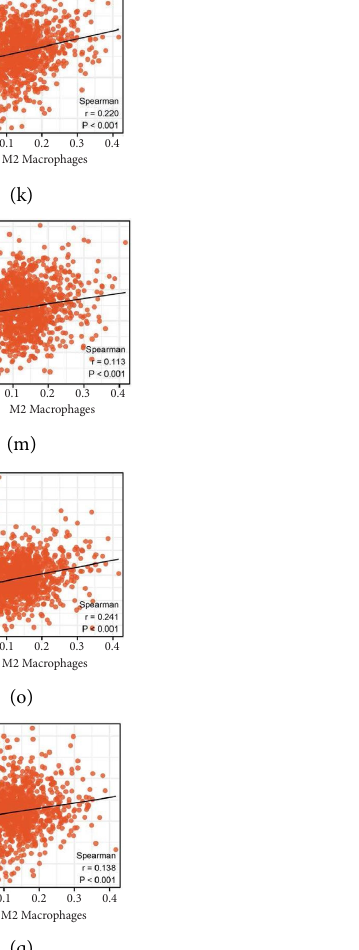
Figure 2: Correlation between M2 macrophages and metabolism. (a) Te ssGSEA algorithm was used to quantify the tumor metabolism status; (b) the coregulation relationship between these metabolic pathways and M2 macrophages; (c)–(r) the correlation of quantifed metabolism terms with M2